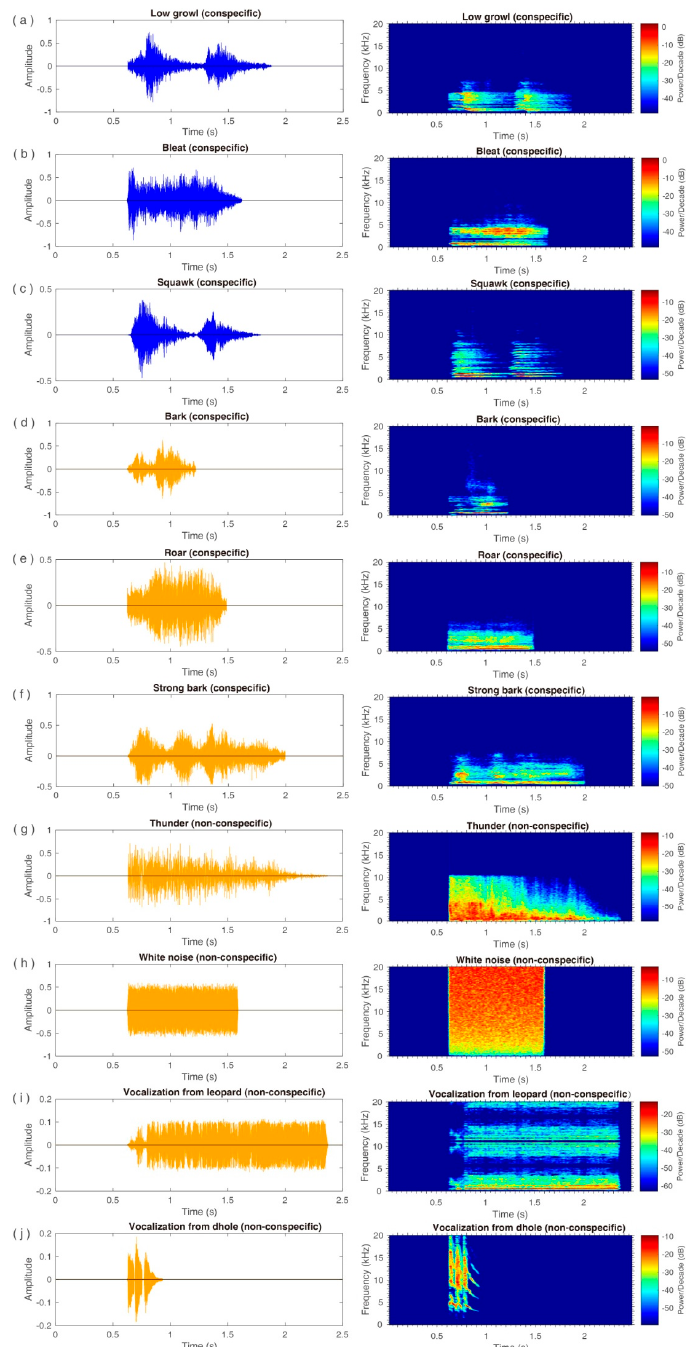
Figure 2. Waveforms and spectrograms of the ten types of stimuli. ( a ) Low growl; ( b ) Bleat; ( c ) Squawk; ( d ) Bark; ( e ) Roar; ( f ) Strong bark; ( g ) Thunder; ( h ) White noise; ( i ) Vocalization from leopard; ( j ) Vocalization from dhole. The blue waves represent the positive stimuli, while the or- ange waves represent the negative stimuli. Note that only one exemplar is shown for conspecific vocalization, while four exemplars were used for each conspecific